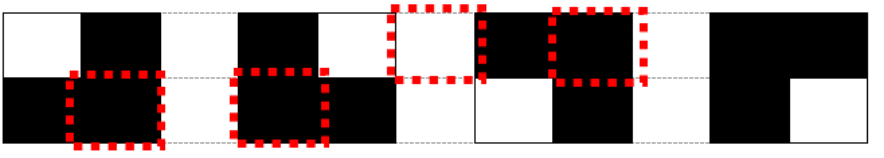
Figure 7. Redundant point direction.